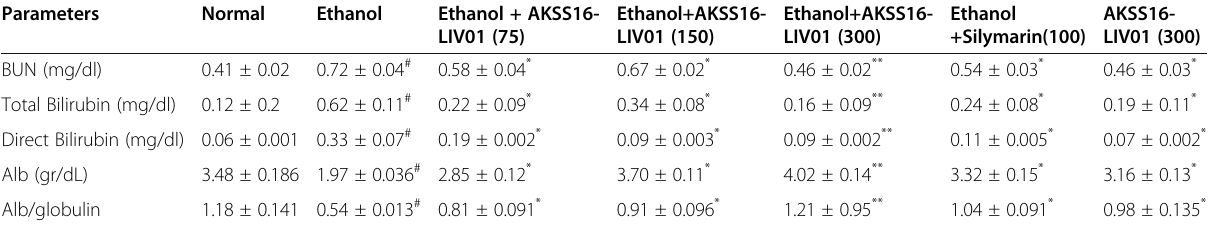
Table 5 Effect of AKSS16-LIV01 on liver function test parameters across the groups in chronic ethanol-induced hepatic damage in mice